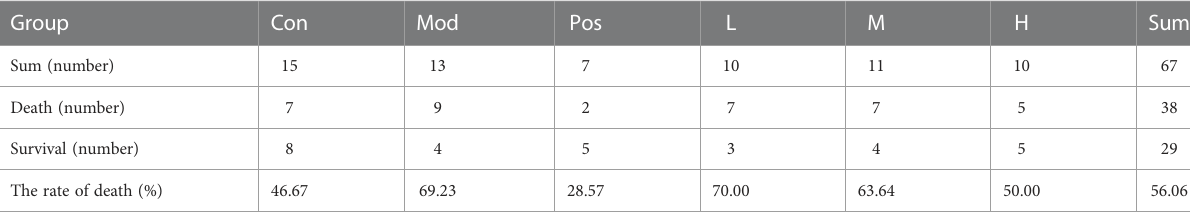
TABLE 1 The effects of Qi-Fu-Yin on survival of aged APP/PS1 transgenic mice induced by environmental cold stress. Group